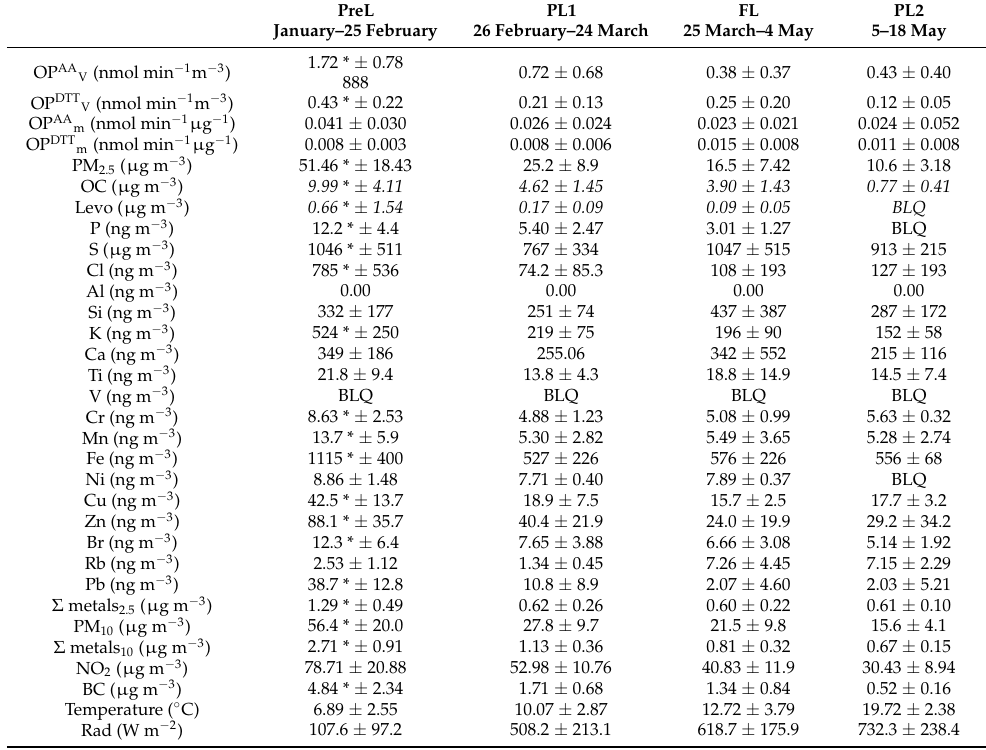
Table 1. The OP responses measured with AA and DTT assays, concentrations of PM 2.5 mass and its chemical components, air levels of atmospheric pollutants (nitrogen dioxide, NO 2 and black carbon, BC), meteorological parameters (ambient temperature and solar radiation). Reported values are means ± standard deviation values computed for each lockdown period. * indicates means with significant differences (Student t -test. p ≤ 0.05) between the periods. BLQ = below quantification limit. Italic values indicate estimated values from data experimentally measured on PM 10